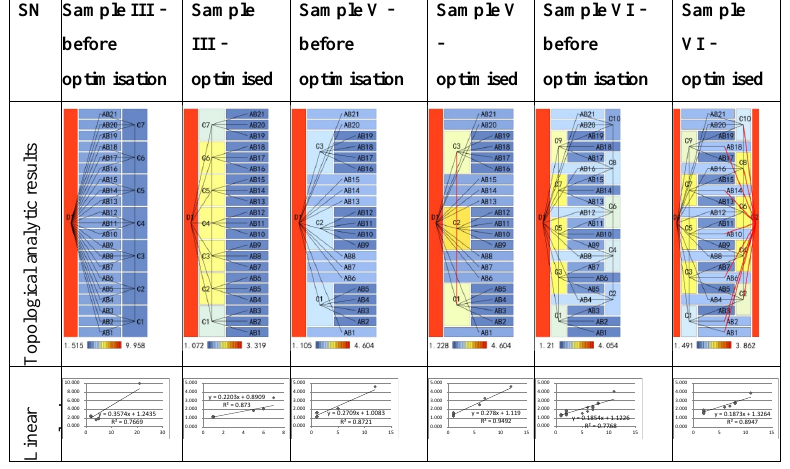
Table 6 Comparative analysis of topological structures before and after